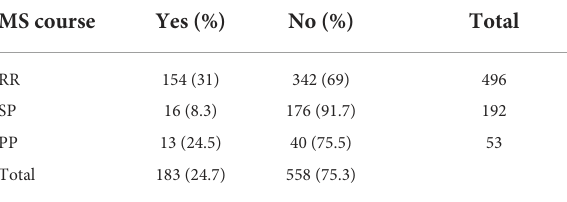
TABLE 1 Exercise practice and MS course ( n =